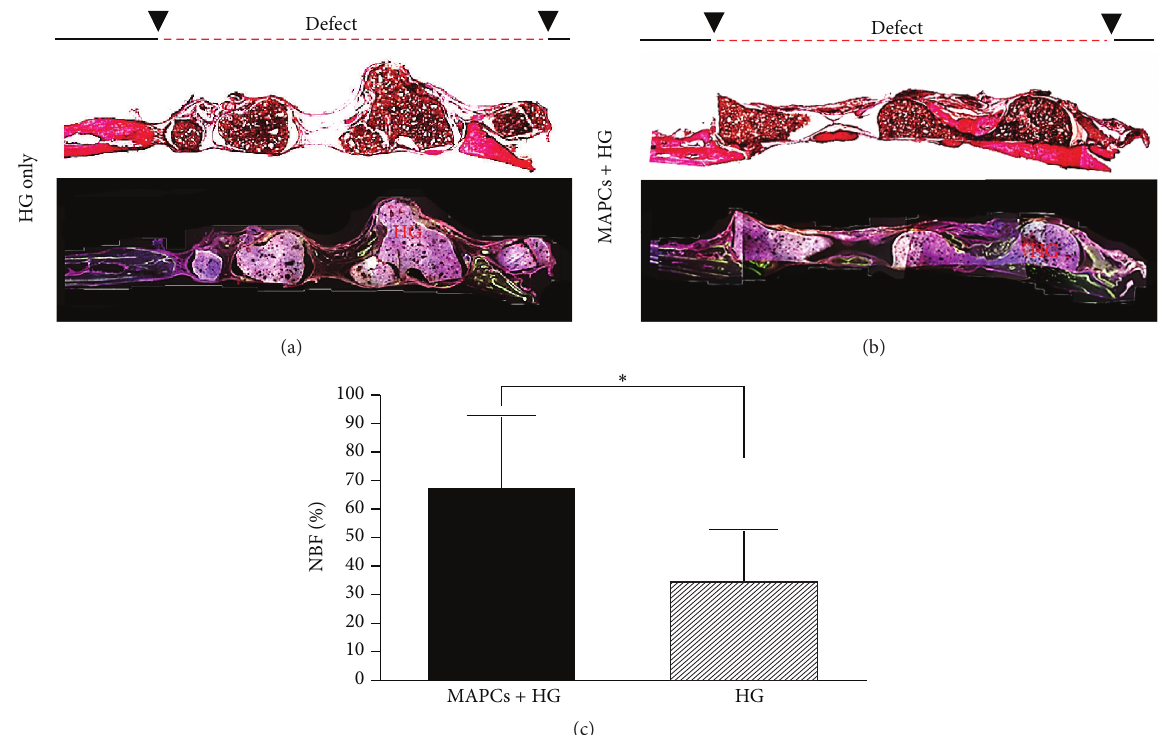
Figure 5: Sagittal section of the defect area after 12 weeks of implantation. Sections were stained with Steven Blue and Van Gieson ((a) and (b), top) and fluorescence image was labeled with Calcein and Alizarin Red S dye ((a) and (b), bottom). The area of new bone formation (NFB) was quantified in % using ImageJ software; ∗ 𝑝 < 0.05